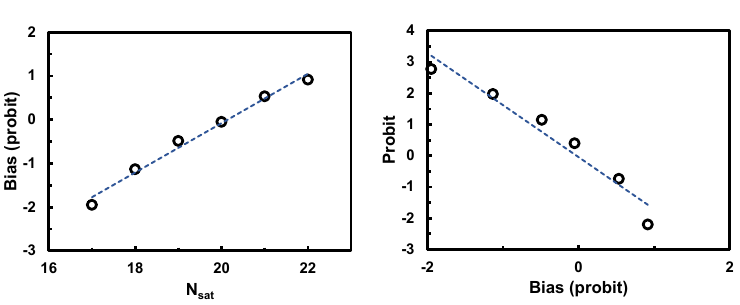
Figure 17: The biased probability of producing “0” or “1” bits by comparing the resistance (described in Subsection 3.1 and Subsection 3.2) for different N sat values. The bias is mapped to the probability of finding N sat (Figure 13), as shown in the right figure. The fitted probability of the RRAM-to-RRAM bias is used for RRAM array simulation.